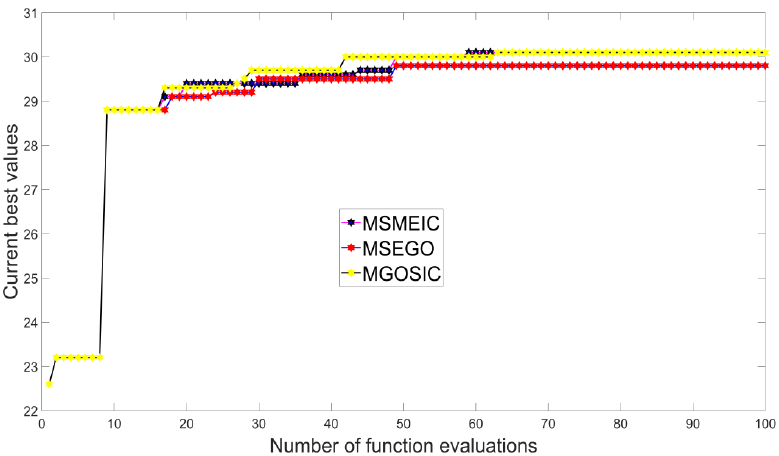
Figure 9. The optimization process of MSMEIC, MSEGO and MGOSIC. Table 9. The specific results of each